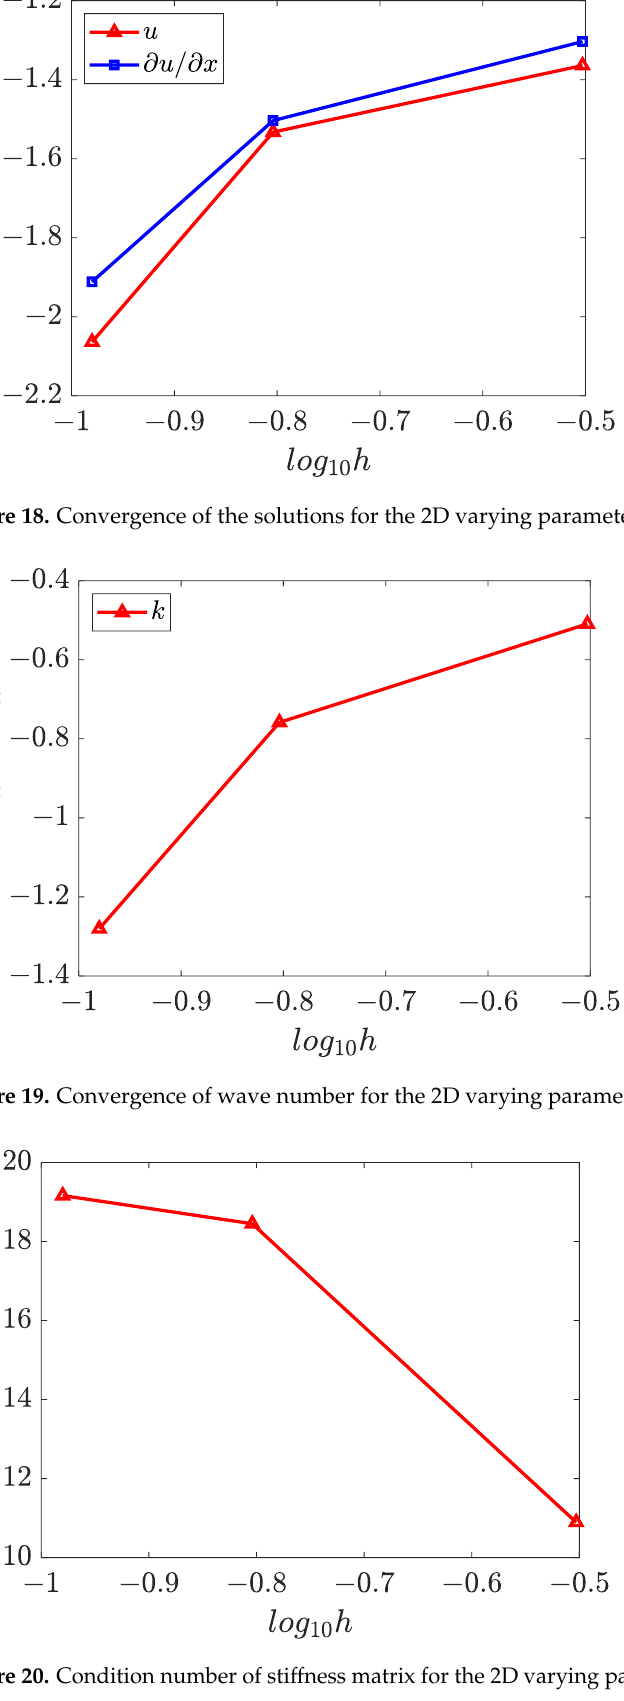
Figure 20. Condition number of stiffness matrix for the 2D varying parameter identification prob- lem.